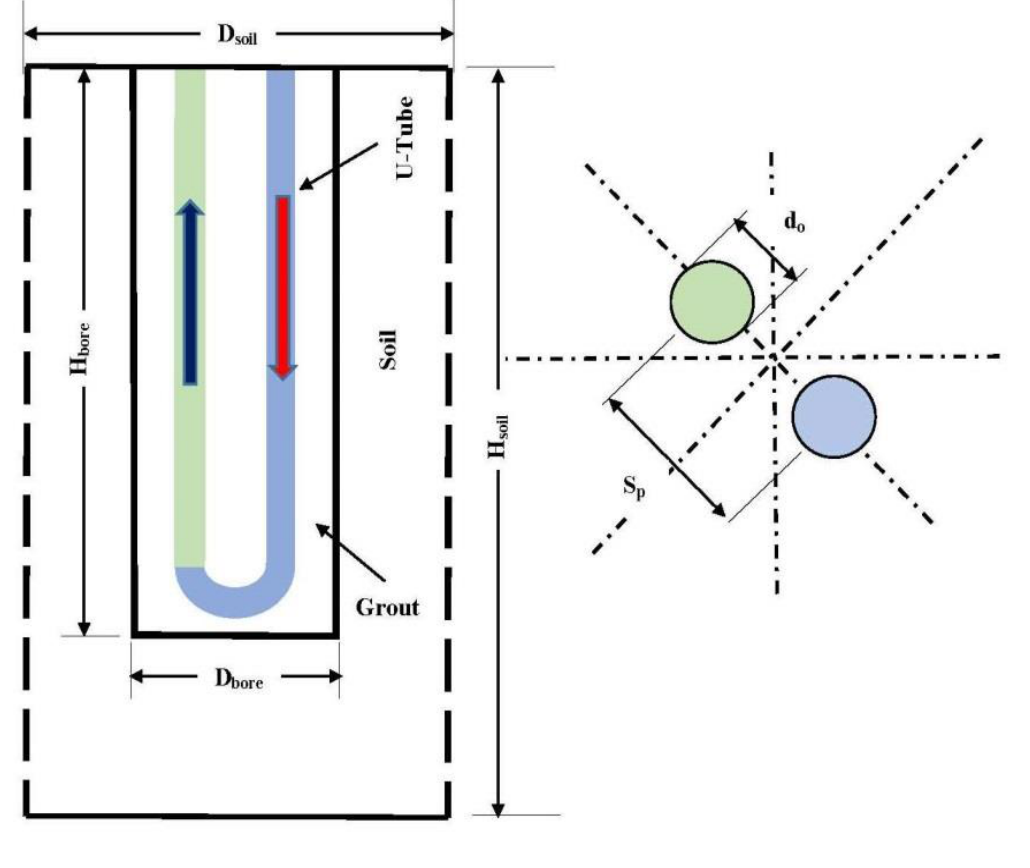
Figure 1.a. Single U-tube heat